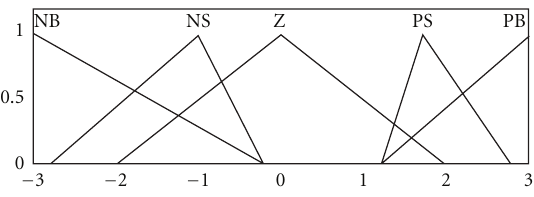
Figure 5: Fuzzy controller input variable “ e ”.